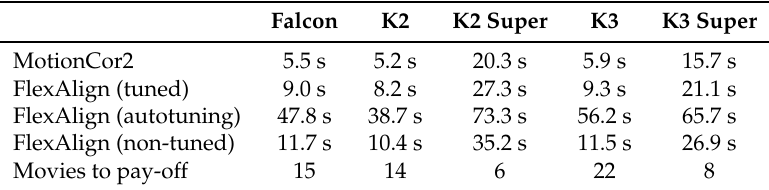
Table 5. Execution time on Testbed 2.